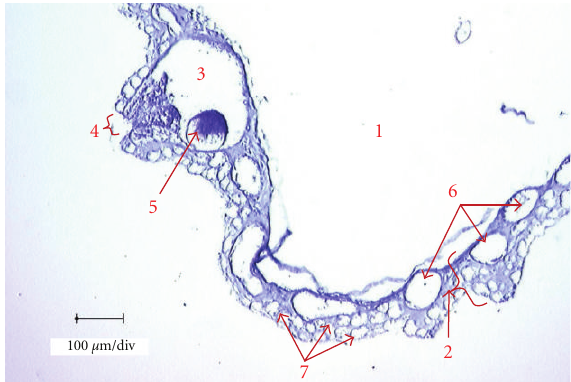
Figure 5: Transverse section of Paracorallium japonicum ; OCA- Cn20080405-022. 1: axis, 2: coenenchyme, 3: siphonozooid, 4: siphonozooid opening, 5: gamete (oocyte), 6: vasucular canals, 7: lacunae of